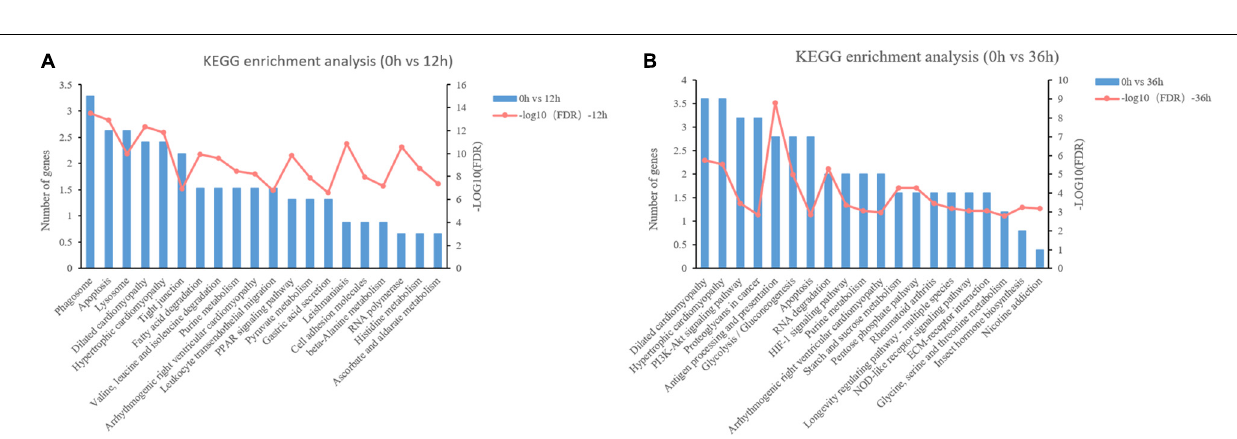
Frontiers in Marine Science |